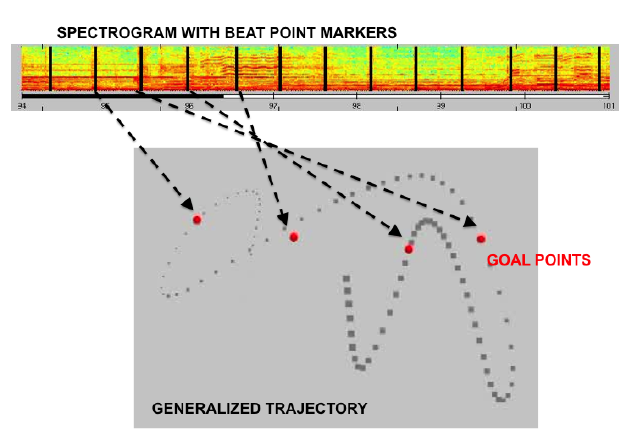
Figure 12. An application: A beating-time gesture for music is made by mapping the goal points (beat times) of a generalised trajectory to the beat points of the music. This is achieved by linear temporal interpolation. The time progress bar shows the actual time stamp of the music and the actual position of the gesture (between beat two and three). This operation changes the run-through speed of the generalised gesture. Additionally the amplitude of the generalised gesture can be changed in accordance with the musical amplitude.